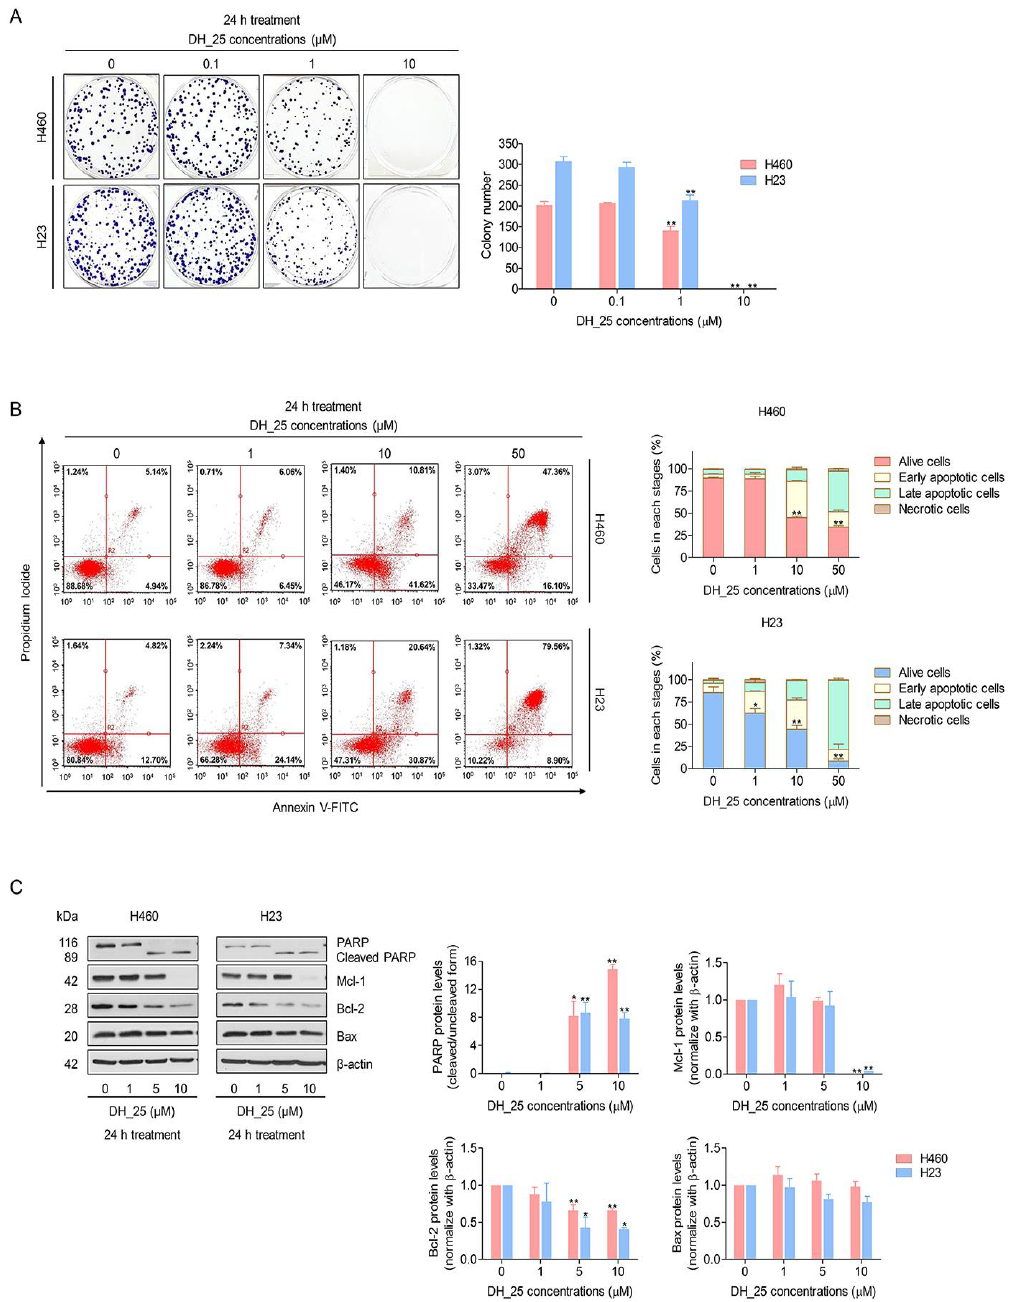
Figure 3. DH-25 inhibits colony formation and induces apoptosis in NSCLC cells (H460 and H23). ( A ) NSCLC cells were seeded and treated with 0–10 µ M of DH_25 for 24 h. The cells were then cultured for seven days before being stained with crystal violet to count the colony number. ( B ) NSCLC cells (H460 and H23) were seeded and treated with 0 – 50 µM of DH_25 for 24 h. Flow cytometry was used to detect apoptotic cells using annexin V-FITC/PI staining. The percentages of cells in each stage were calculated. ( C ) NSCLC cells (H460 and H23) were seeded and treated with 0–10 µ M of DH_25 for 24 h. Western blot analysis was performed to detect the protein levels of PARP, cleaved PARP, Mcl-1, Bcl-2, and Bax. The blots were reprobed with β -actin to confirm an equal loading. Densitometry was used to calculate protein expression levels, and results were presented as fold changes relative to the uncleaved form, or β -actin. The uncropped blotting bands are presented in Figure S6. Data are presented as the mean ± SD ( n = 3) (* 0.01 ≤ p < 0.05, ** p <0.01, compared with the untreated